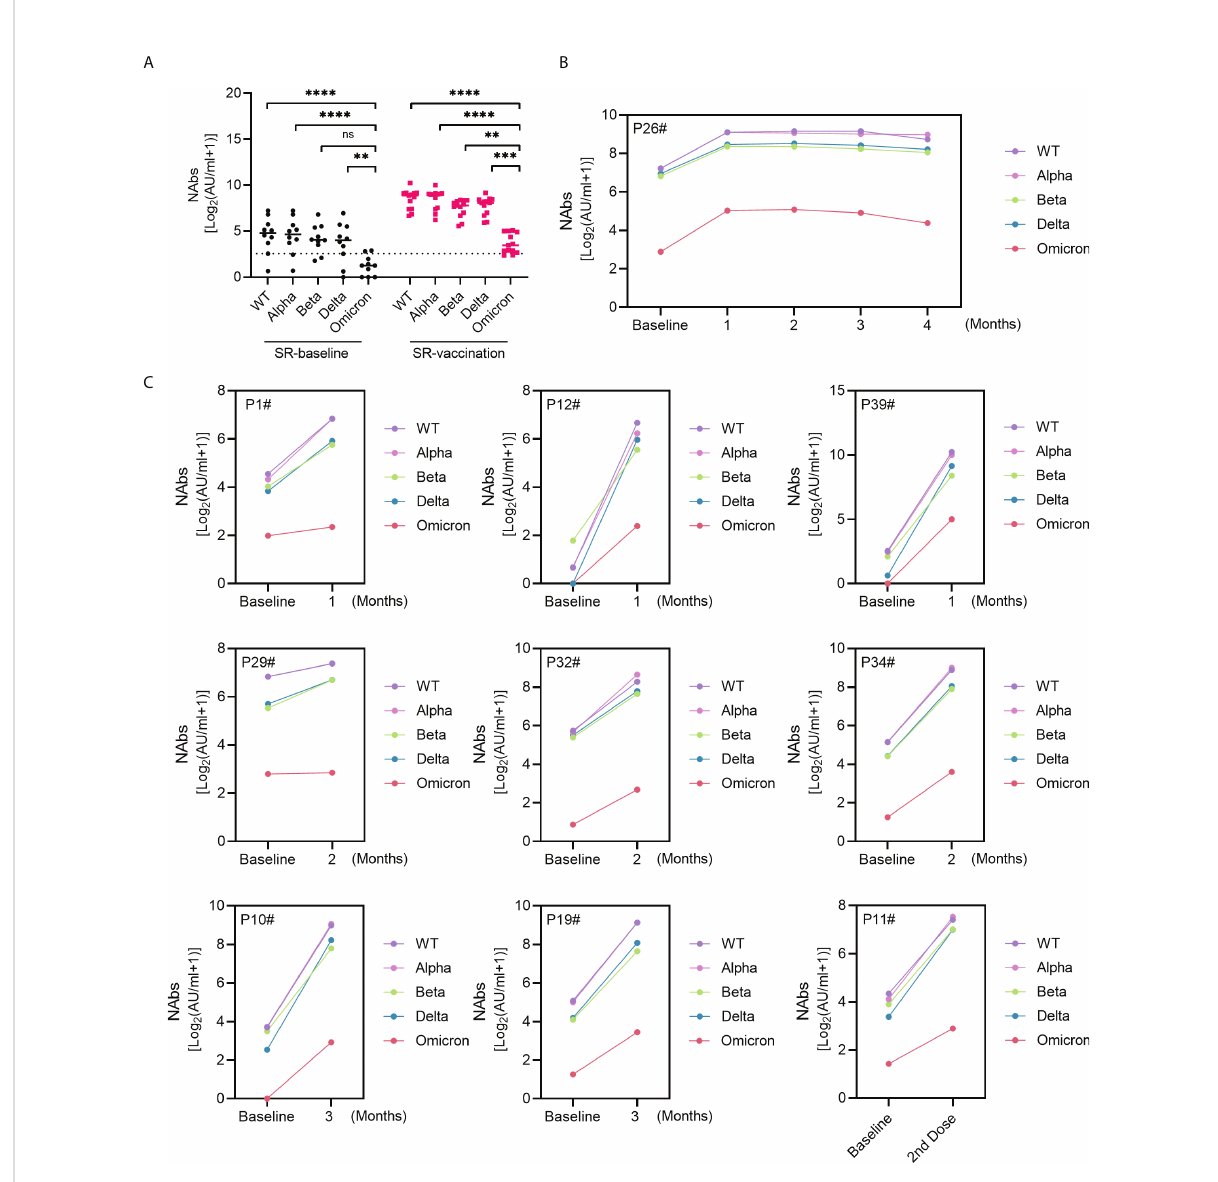
FIGURE 4 NAbs against Omicron in SARS-CoV-2 recovered patients following inactivated vaccination. (A) The comparison of NAbs between Omicron variant and WT or VOC. (B, C) Sequential response of NAbs against Omicron and other virus types in 10 SARS-CoV-2 recovered patients. Kruskal-Wallis test was used for statistical analysis. ns: no signi fi cance, ** P <0.01, *** P < 0.001, **** P <